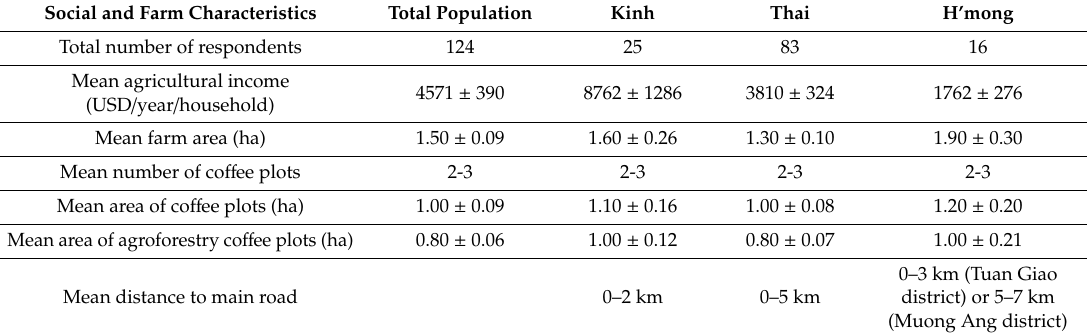
Table 1. Social and plot characteristics of the co ff ee farms; data are the mean values with standard